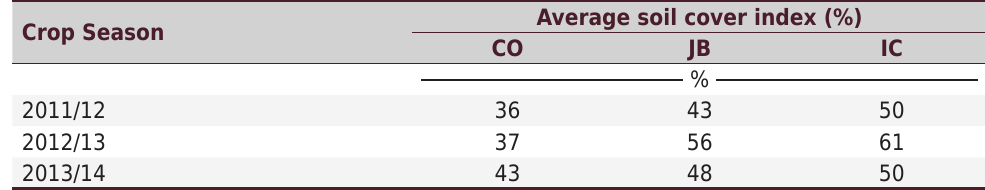
Table 6. Average soil cover index for the three crop seasons from November to March of 2011 to 2012, 2012 to 2013, and 2013 to 2014 in Lavras, MG, Brazil Crop Season